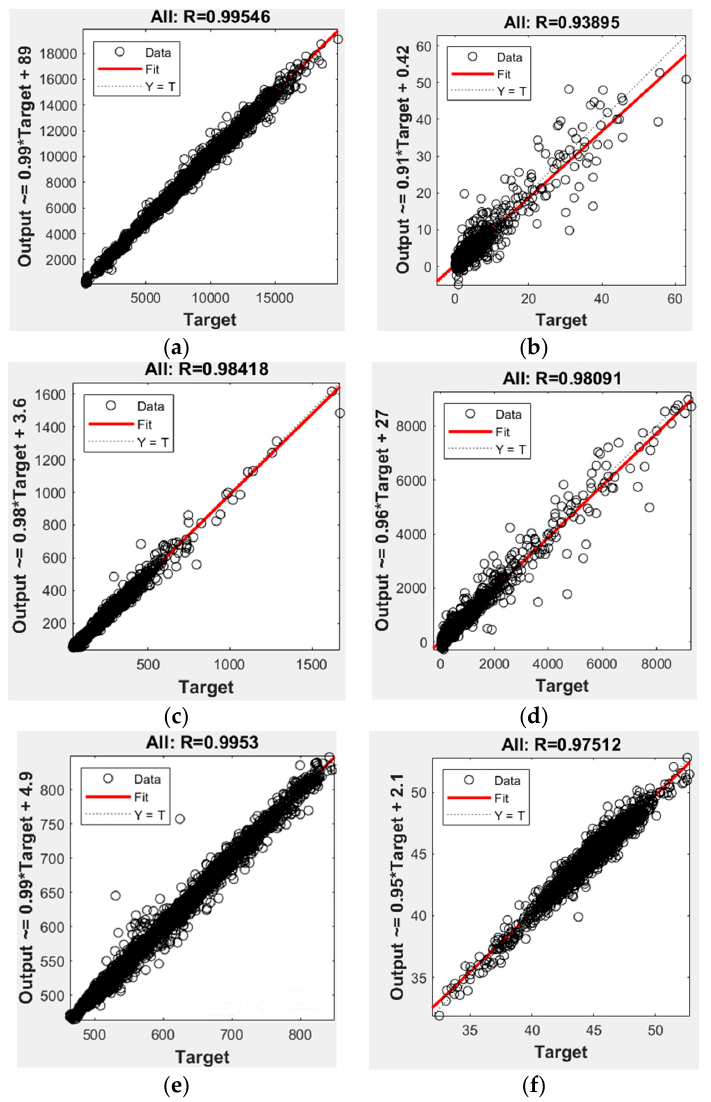
Figure 5. ( a ) NOx ( b ) Soot ( c ) HC ( d ) CO ( e ) Exhaust gas temperature ( f ) Thermal efficiency. Results of prediction based on artificial neural network (ANN) .